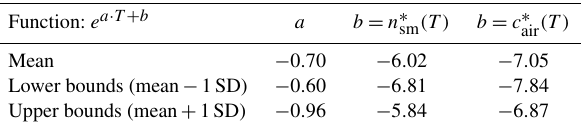
Table 3. Coefficients of the INP concentration parameterization, based on values between 0.2 and 90 INPs per milliliter and 0.08 and 36m − 3